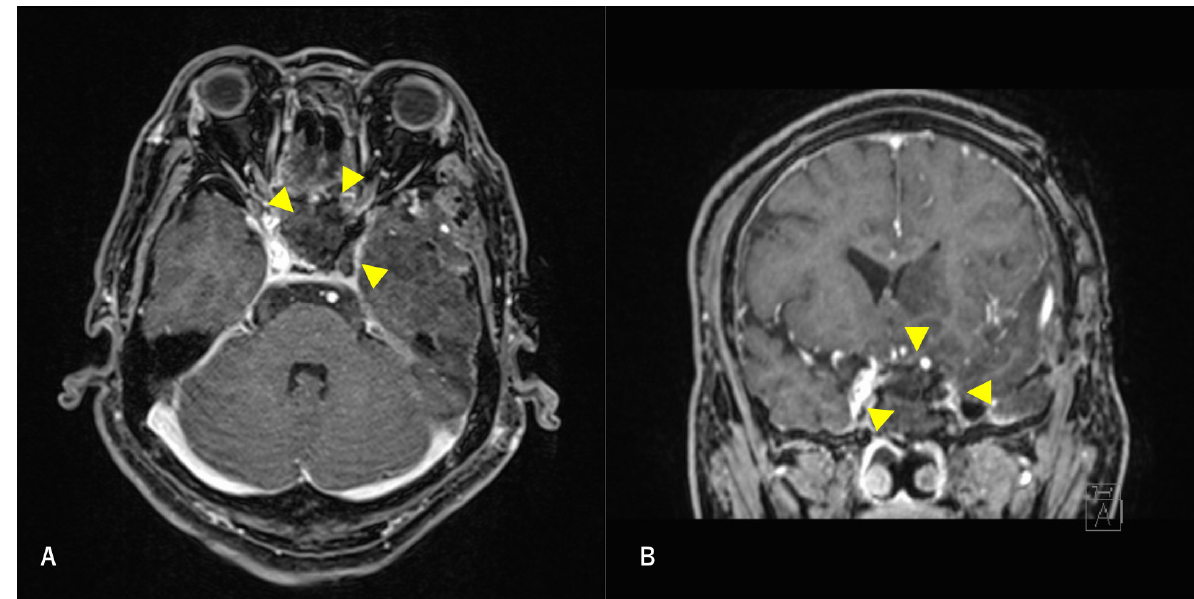
Figure 4. Postoperative T1-weighted contrast-enhanced MRI findings. Axial section ( A ) and coronal ( B ) images are shown. The tumor is confirmed to be resected along with the ICA. Arrowheads indicate the site of tumor removal.